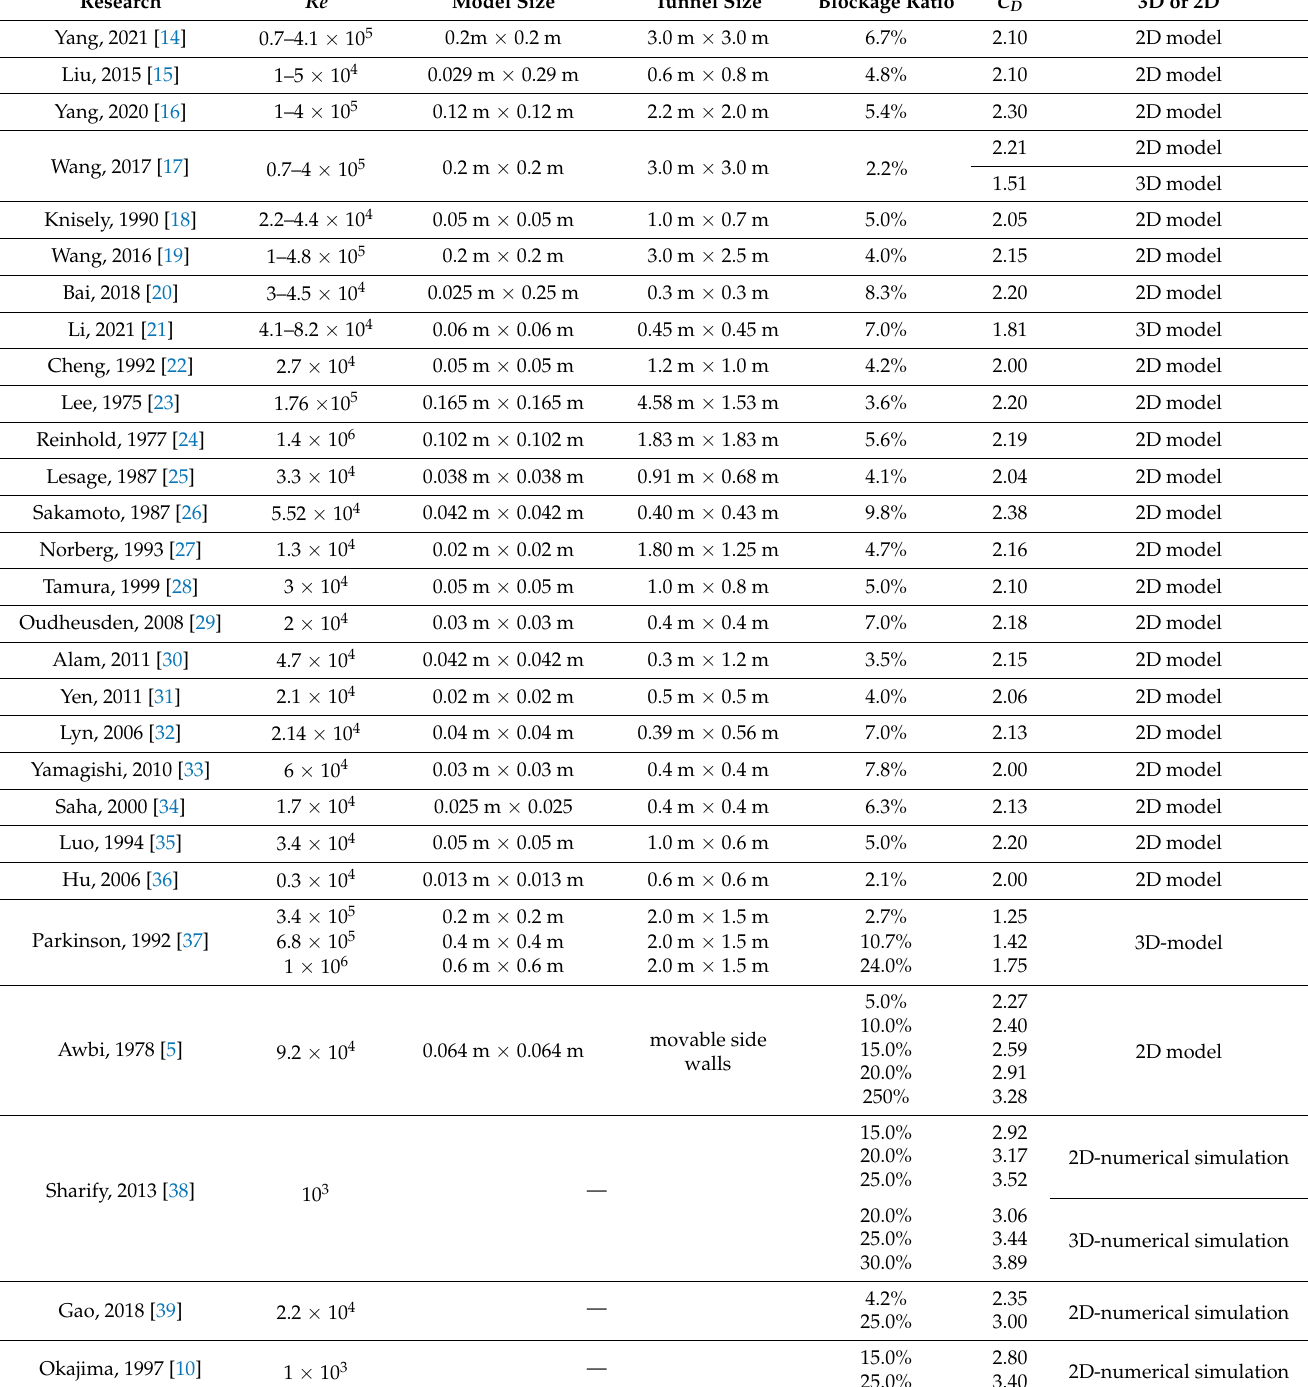
Table 4. The drag coefficient results from existing